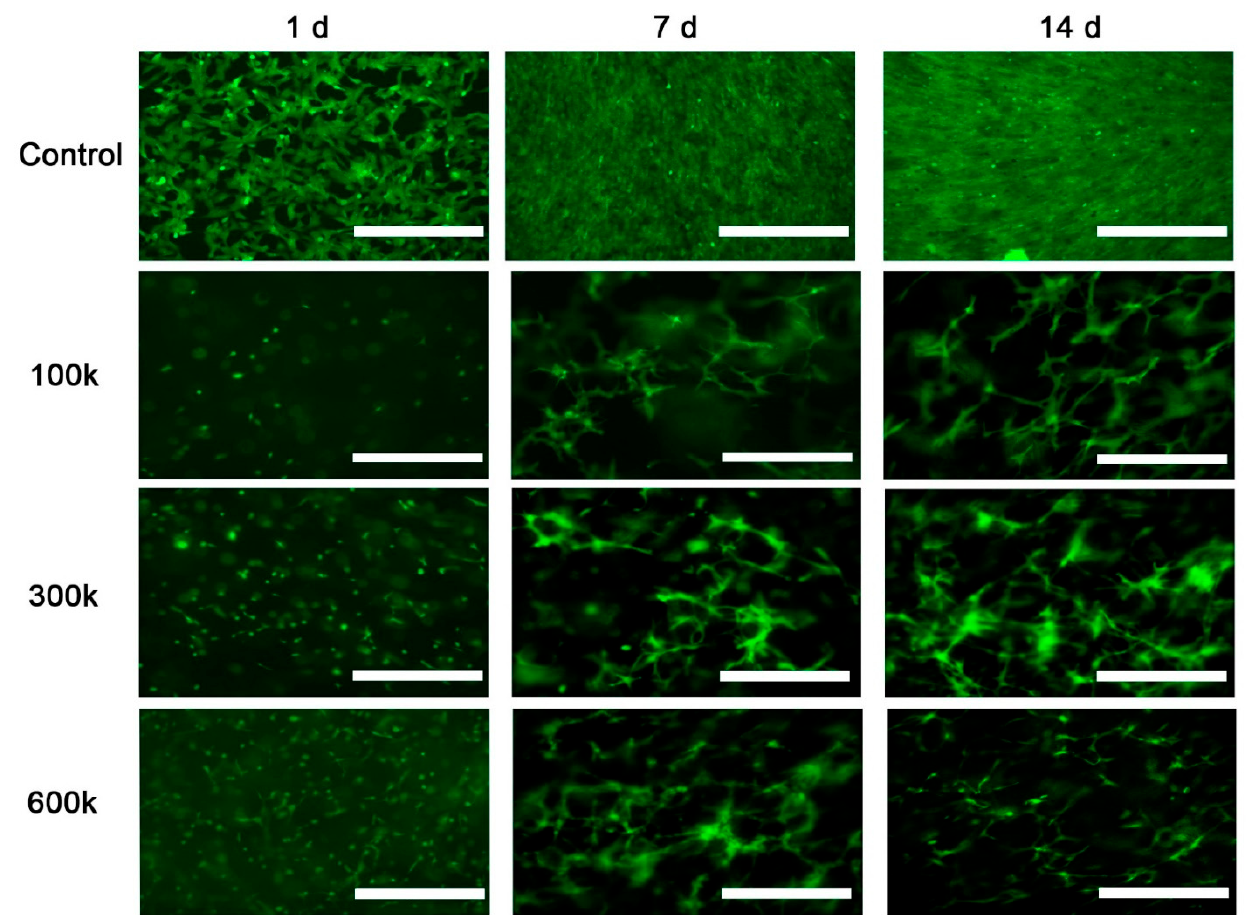
Figure 1. Vascular network formation (VNF) by HPMEC detected by fluorescent microscopy imaging; 100k, 300k, and 600k HPMEC in LV ECM hydrogel were examined after 1, 7, and 14 days. As control, HPMEC were seeded directly on culture plastic. Scale bars represent 400 µm.